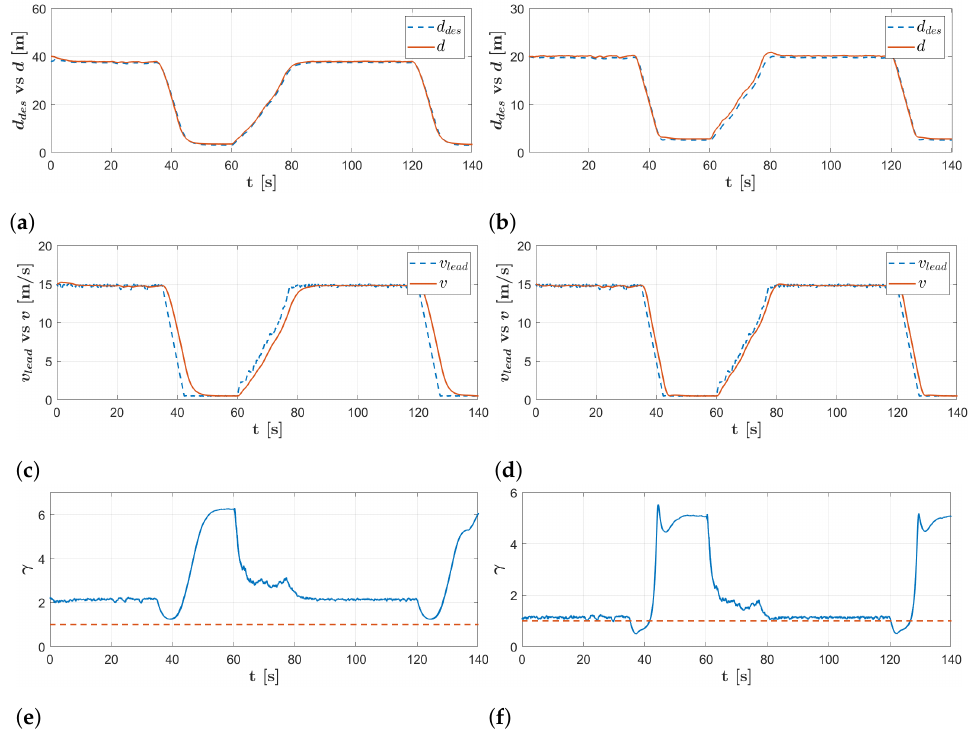
Figure 11. Road-Grip aware Driving Functionalities during Stop&Go. Time-history of the current distance gap, d , and of the desired one, d des ( a ) ego velocity v and leader velocity v lead ( c ) safety index, γ ( e ) with road grip adaptation. Time-history of the current distance gap, d , and of the desired one, d des ( b ) ego velocity v and leader velocity v lead ( d ) safety index, γ (f) without road grip